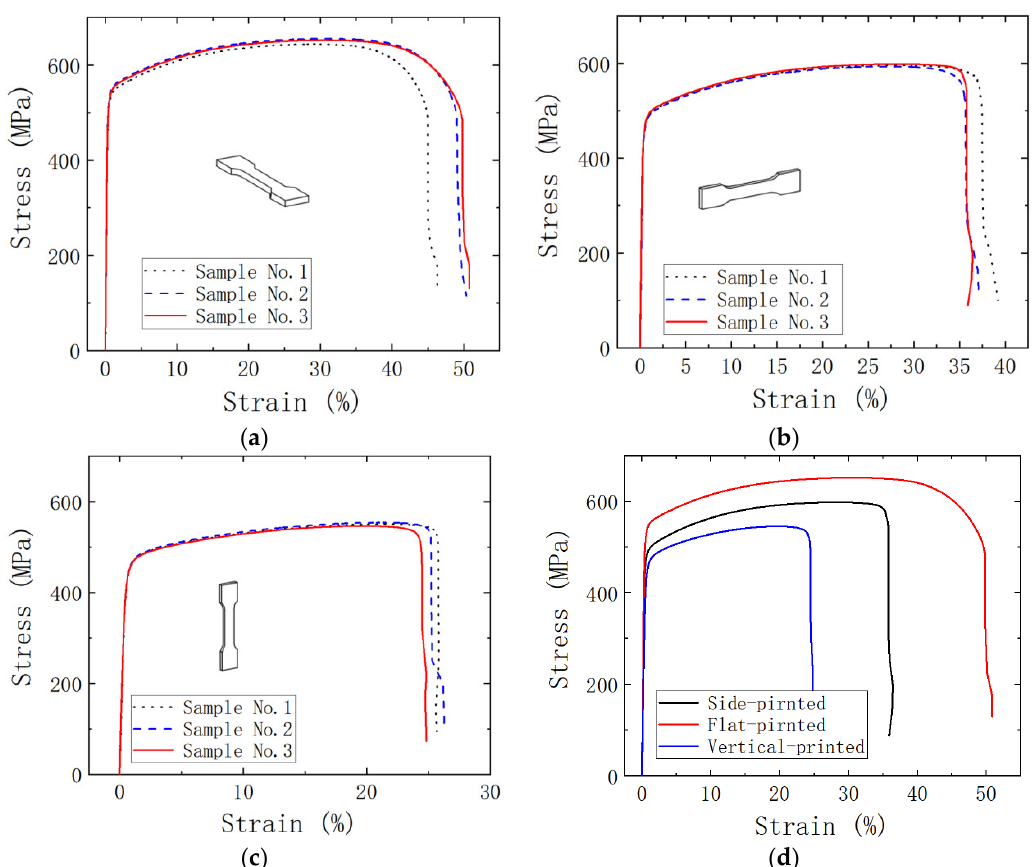
Figure 9 . Stress–strain curve: ( a ) flat; ( b ) side; ( c ) vertical; ( d ) three directions .